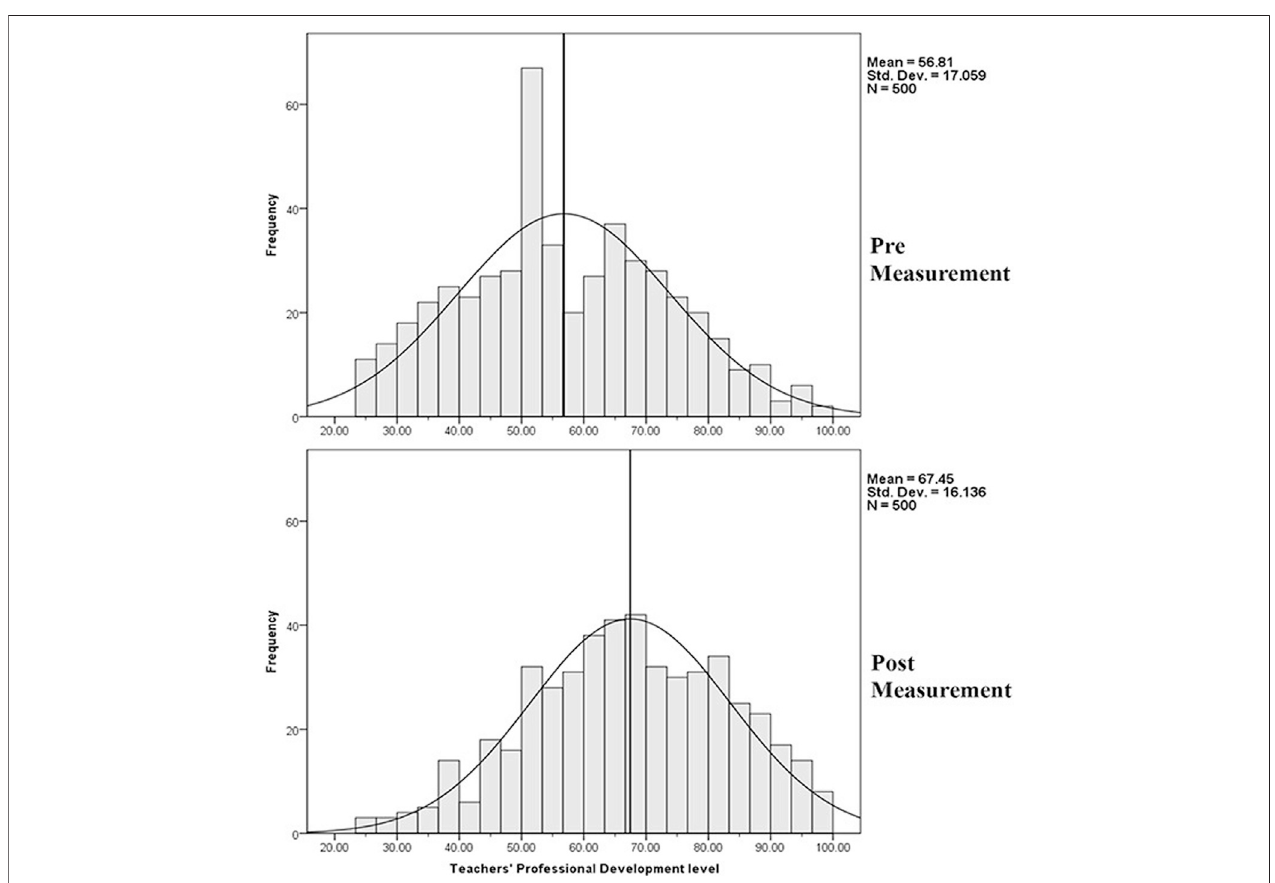
FIGURE 5 | Frequencies of the school scores in the teachers ’ professional development level. In the graph are presented the results from the pre and the post- measurements. The vertical line illustrates the mean value of school scores.